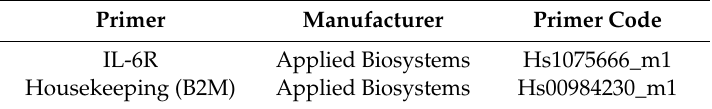
Table 4. Primers utilized for quantitative polymerase chain reaction